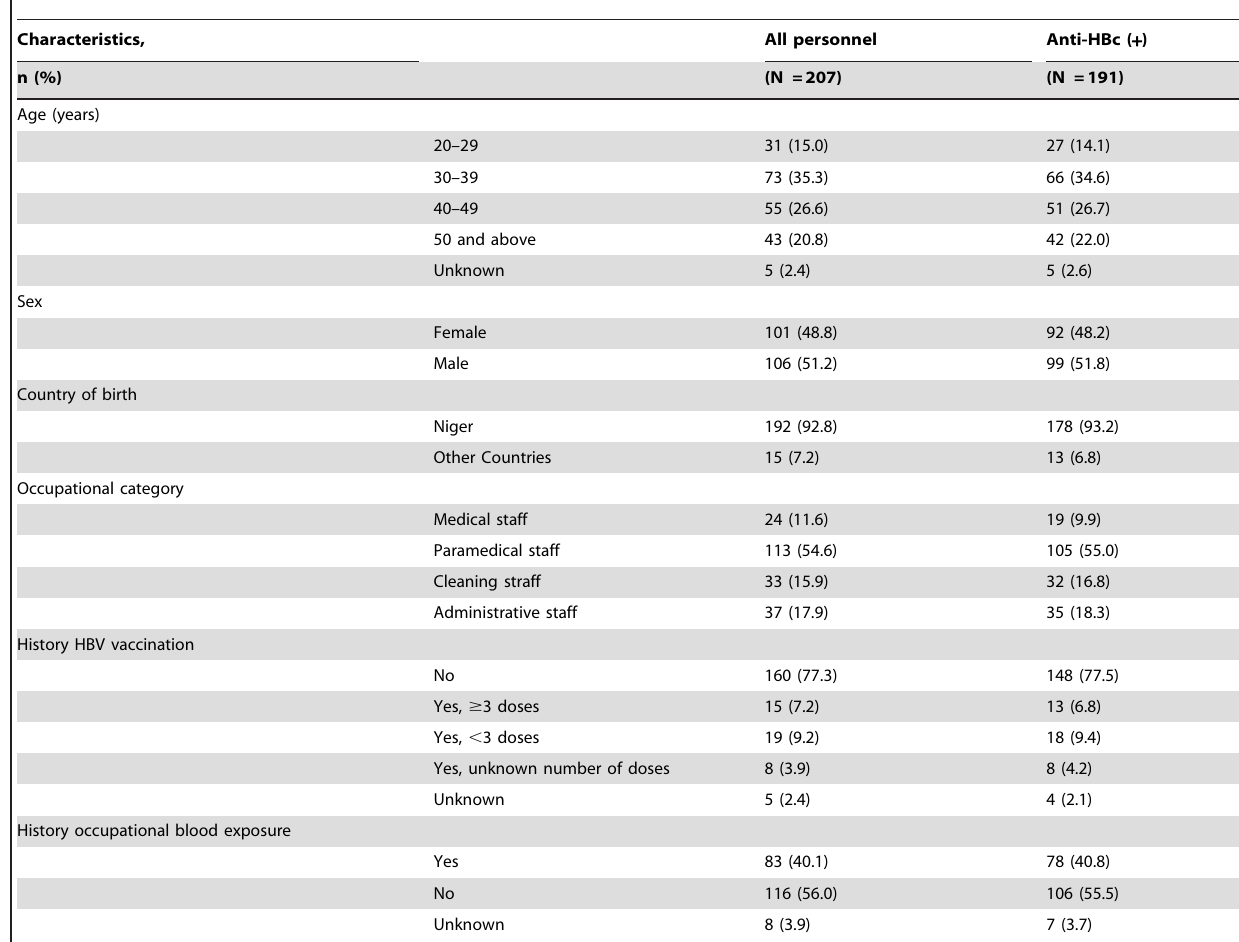
Table 1. Characteristics of personnel (n=207) at Niamey’s National Hospital, Niger, 2009.